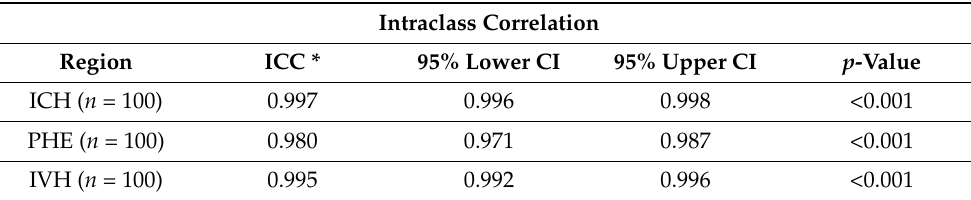
Table 3. Intraclass Correlation of one rater for semimanual volume segmentation of intracerebral hemorrhage and intraventricular hemorrhage stratified across two readings.